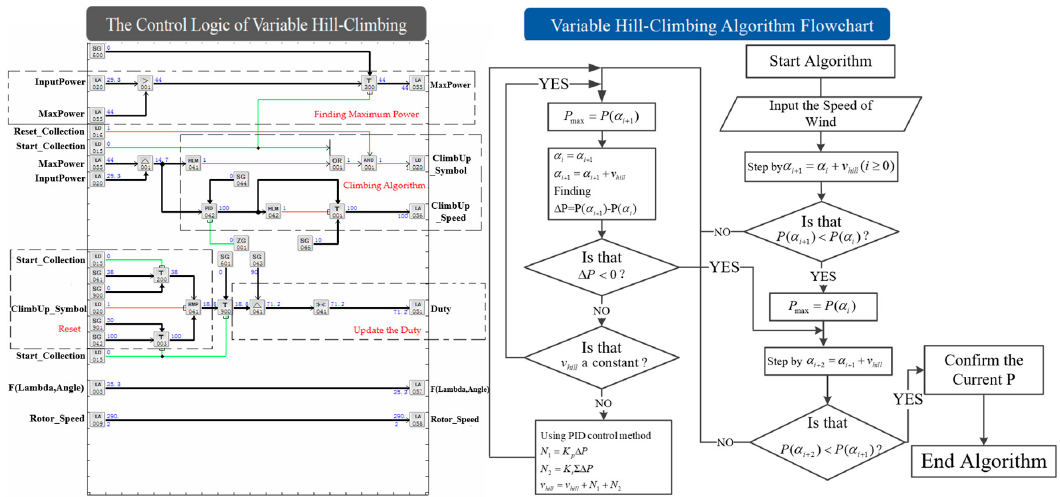
Energies 2018 , 11 , x Figure 9. The algorithm flowchart and control logic of variable hill-Climbing. Figure 9. The algorithm flowchart and control logic of variable hill-Climbing.